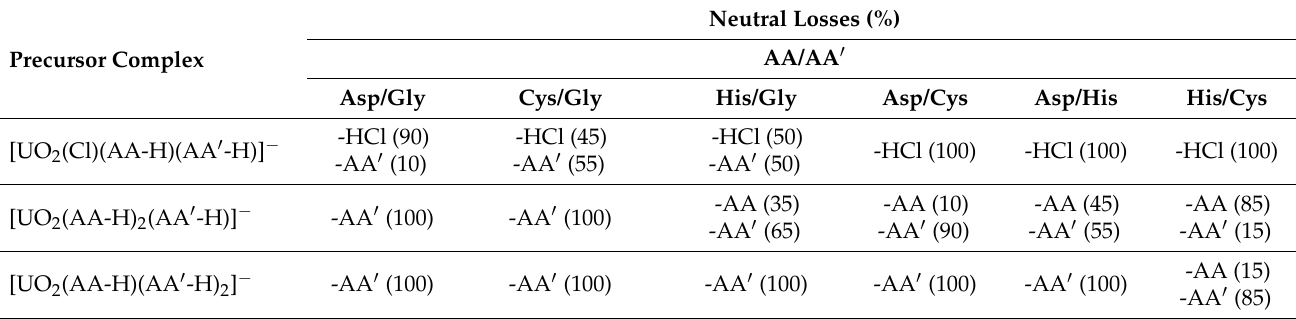
Table 4. Competitive CID of anionic uranyl–amino acid